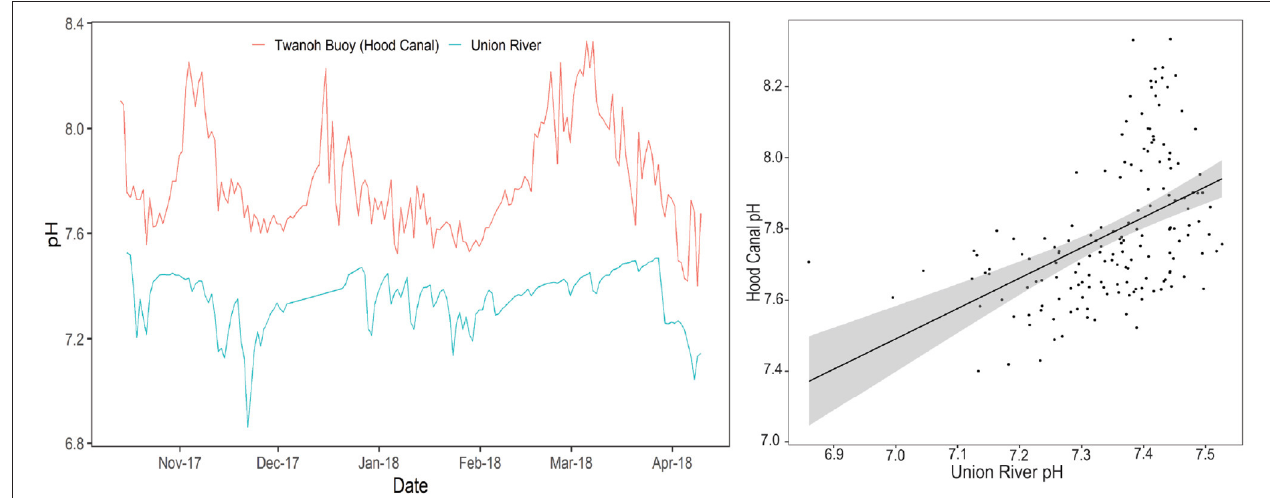
FIGURE 5 | (Left) Daily average pH in the Union River and in the Hood Canal measured at the Twanoh Buoy by (ORCA-UW, 2018) from October 13th, 2017 to April 9th, 2018. Date is displayed as Month-YY. (Right) Daily average pH in the Union River compared to the Hood Canal ( r = 0.47, p < 0.001).